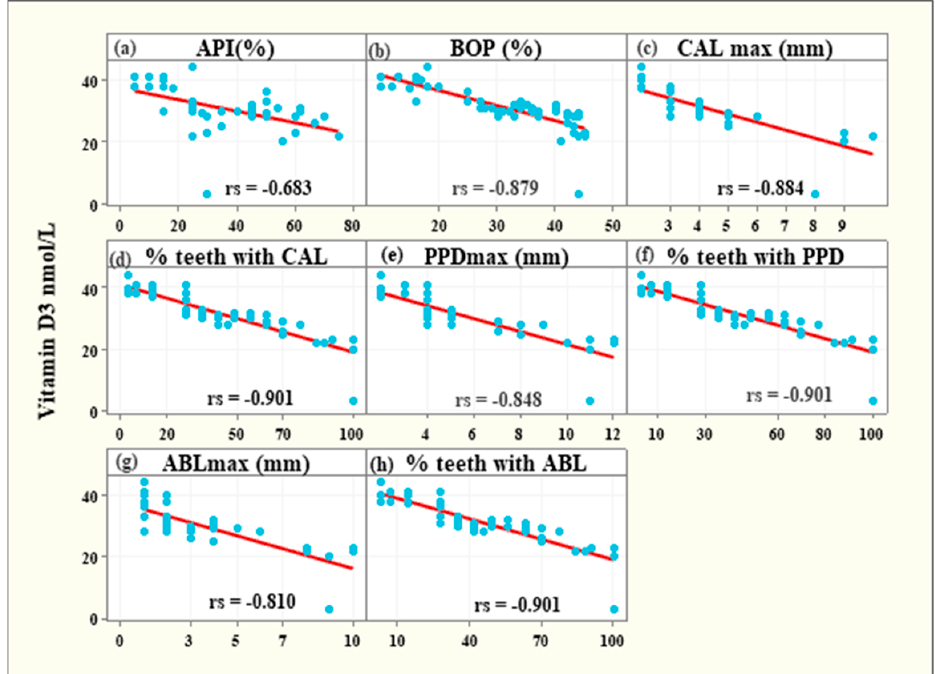
Figure 3. Strong negative associations between vitamin D3 levels and API ( a ), BOP ( b ), CALmax ( c ), % teeth with CAL ( d ), PPDmax ( e ), % teeth with PPD ( f ), ABLmax ( g ) and % teeth with ABL ( h